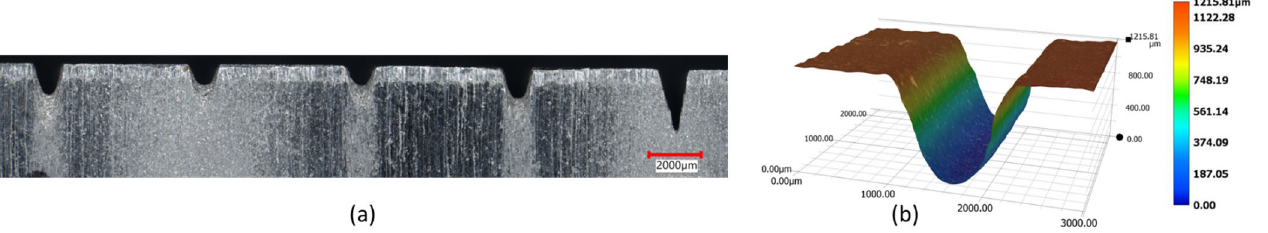
Figure 2. Indicative images of the produced slots: ( a ) 2D image of the produced slots under various process conditions, ( b ) 3D representation of the produced slot.